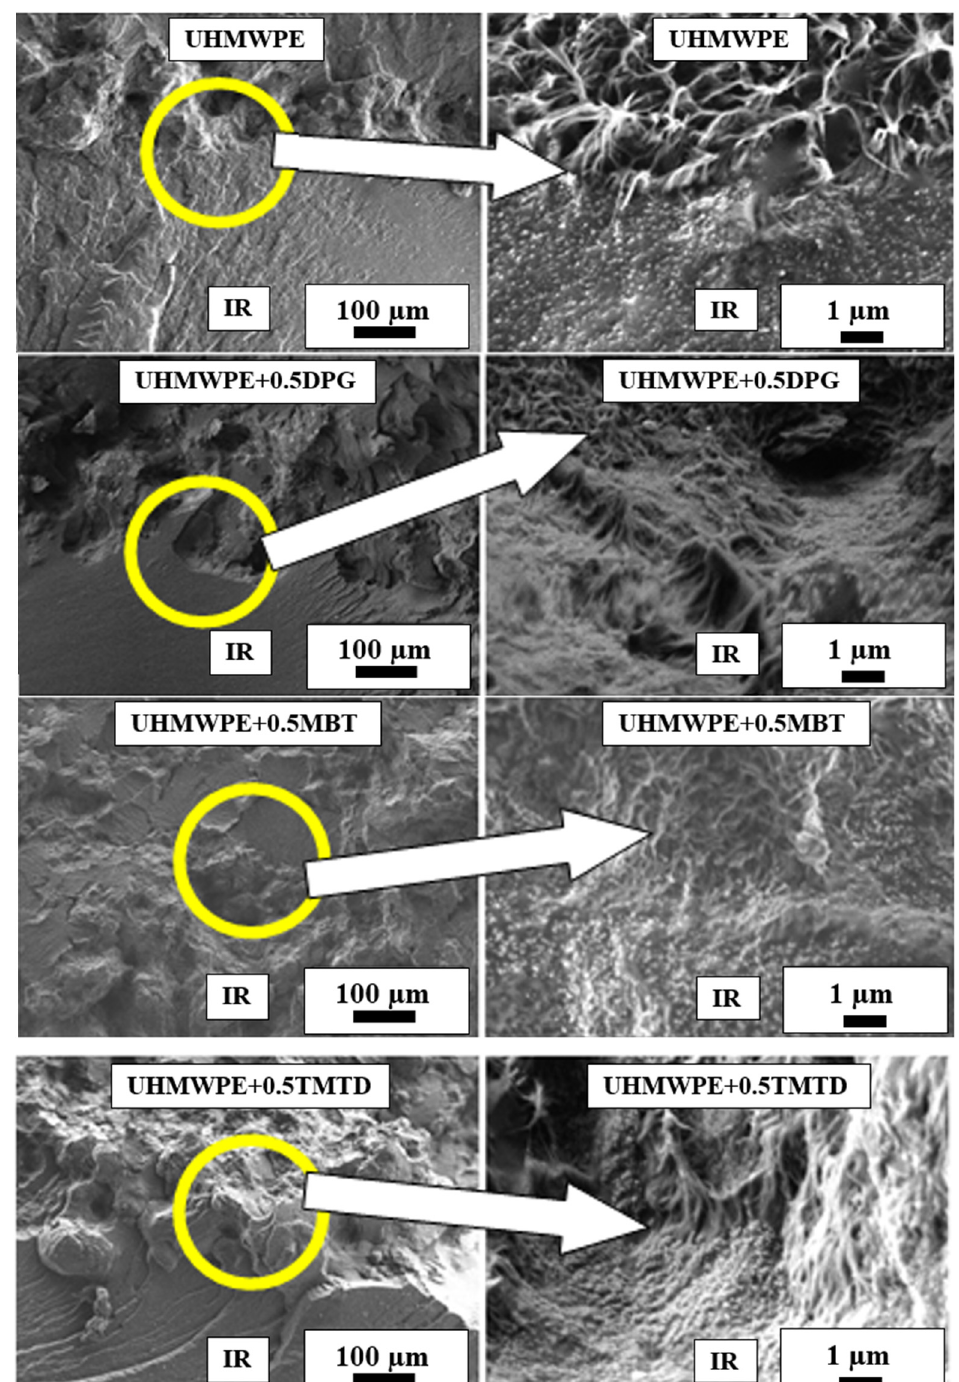
Figure 9. Phase boundary of interaction between IR rubber and UHMWPE.